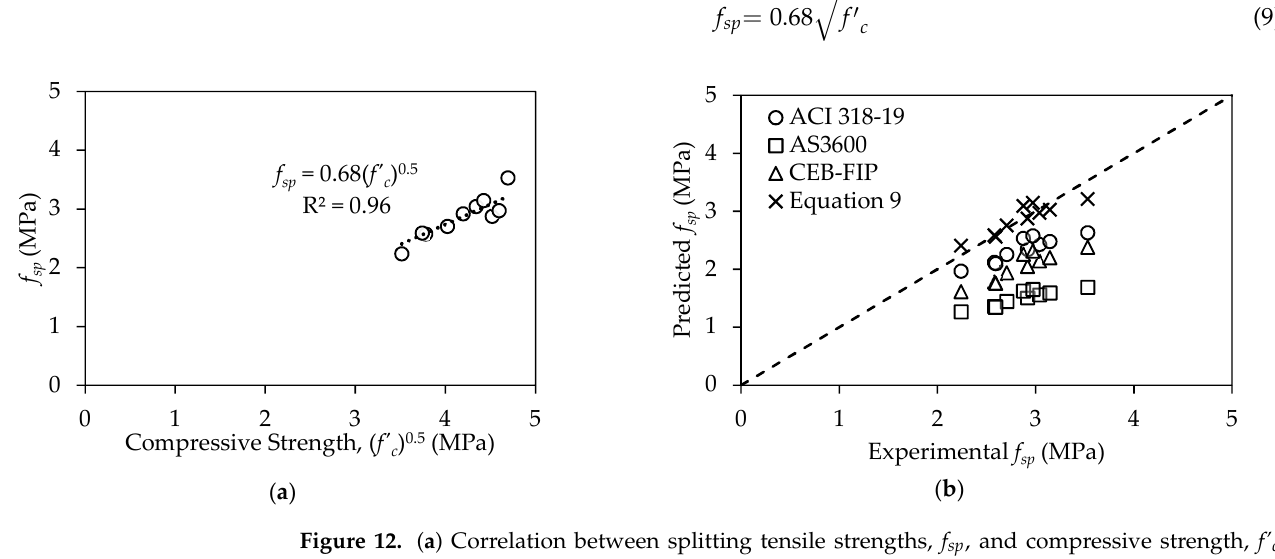
Table 9. Equations relating splitting tensile strength and compressive strength.